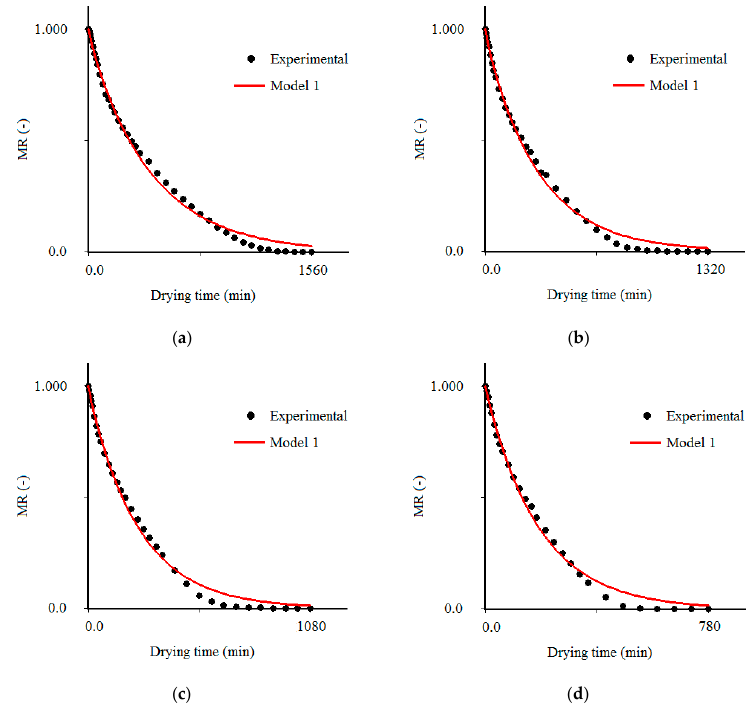
Figure 3. Comparison of dimensionless moisture contents obtained in the experiment and predicted using model 1 at drying air temperatures of ( a ) 50 °C, ( b ) 60 °C, ( c ) 70 °C and ( d ) 80 °C.